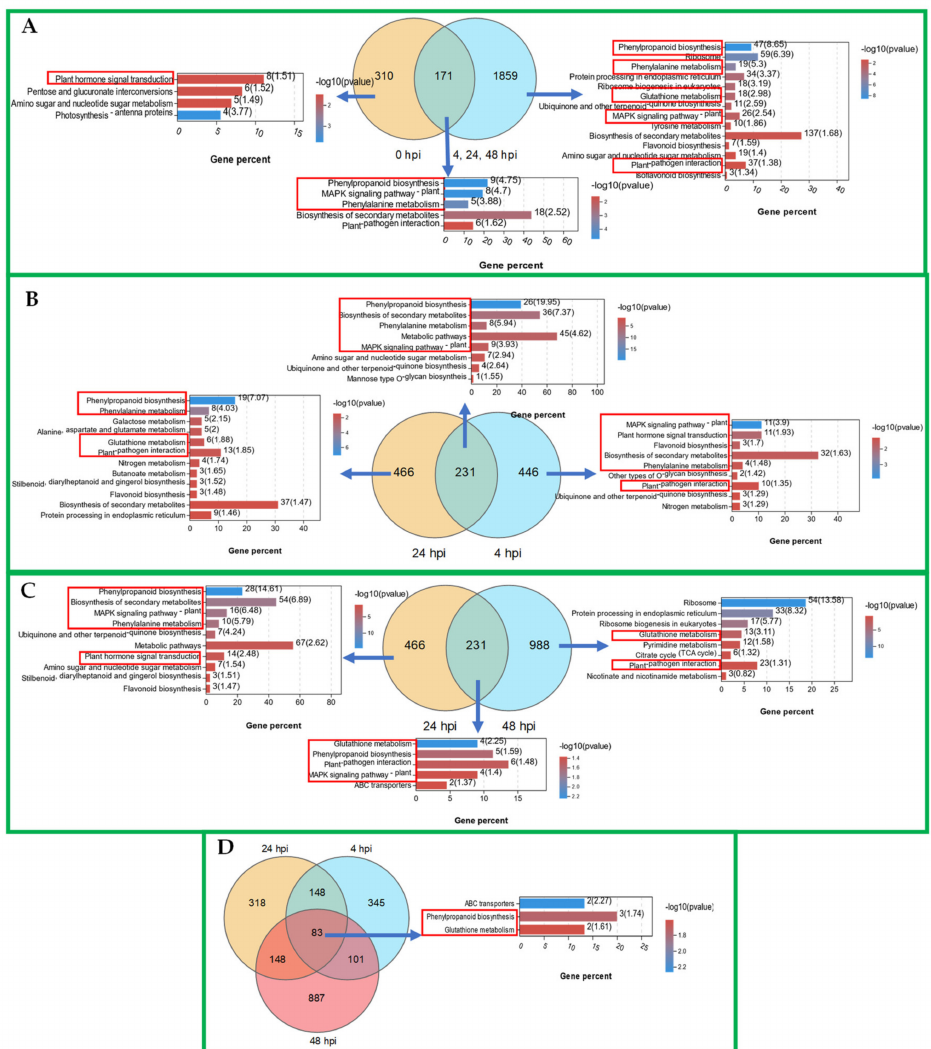
Figure 5. Venn analysis and KEGG enrichment analysis of up − regulated